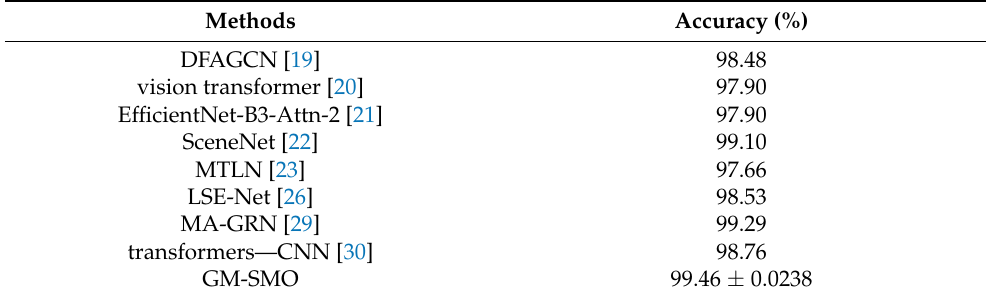
Table 5. GM-SMO is compared with existing methods on the UCM dataset.